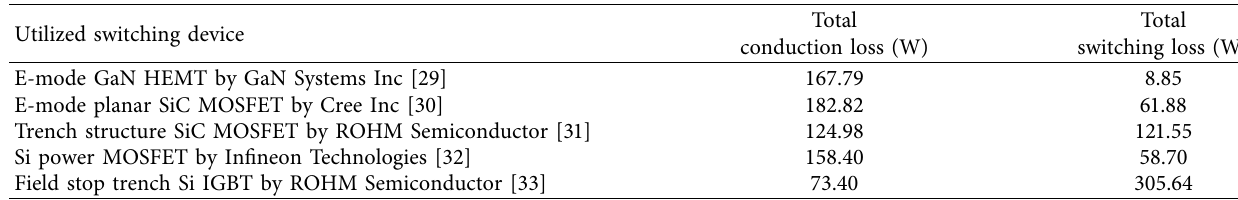
Table 2: Loss comparison of the proposed